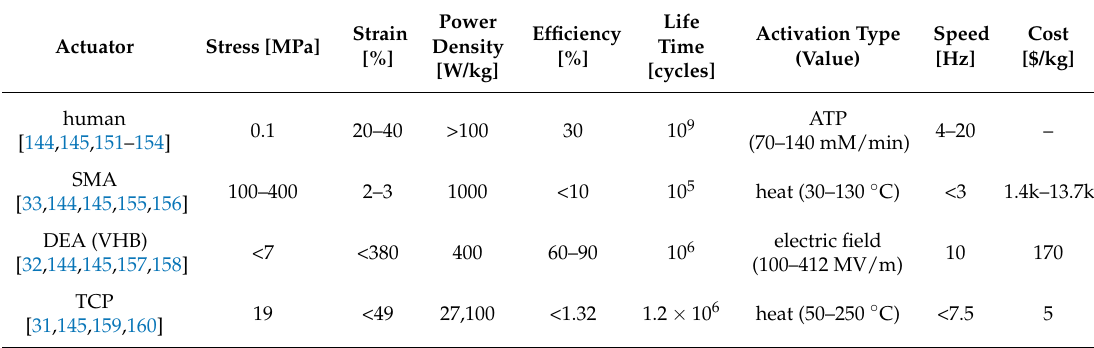
Table 4. Comparison of artificial and human